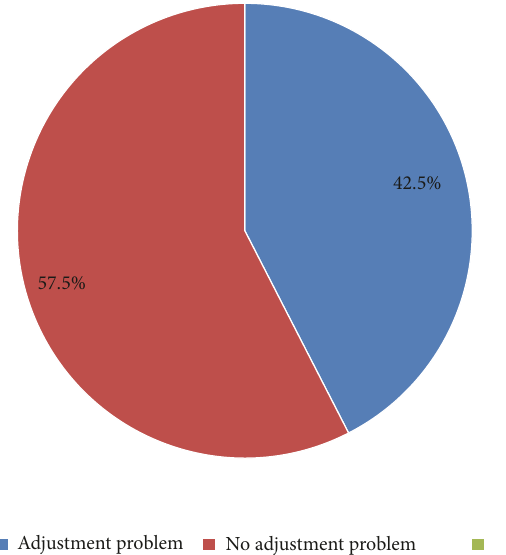
Figure 1: Prevalence of adjustment problem among university students in Dilla University, Southern Ethiopia, 2016